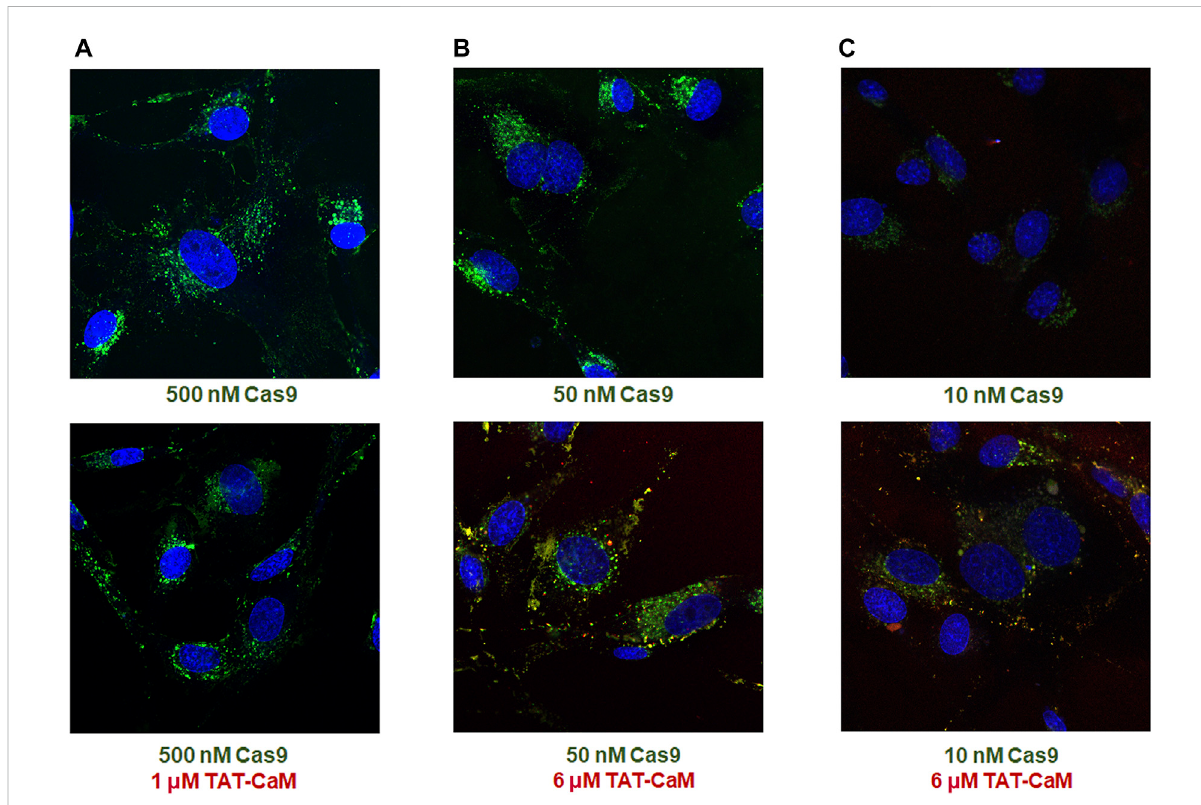
FIGURE 3 Speci fi c and nonspeci fi c Cas9 internalization with the TAT-CaM. BHK cells in DMEM with 10% FBS were treated for 1 h with Cas9-NLS in the absence (top) or presence (bottom) of excess TAT-CaM prior to washing (PBS x3) and imaging. Cas9-NLS at concentrations > 50 nM showed no increase in internalization with inclusion of TAT-CaM as shown in examples (A) 500 nM and (B) 50 nM; however, at low Cas9-NLS concentrations including (C) 10 nM, TAT-CaM speci fi cally increased